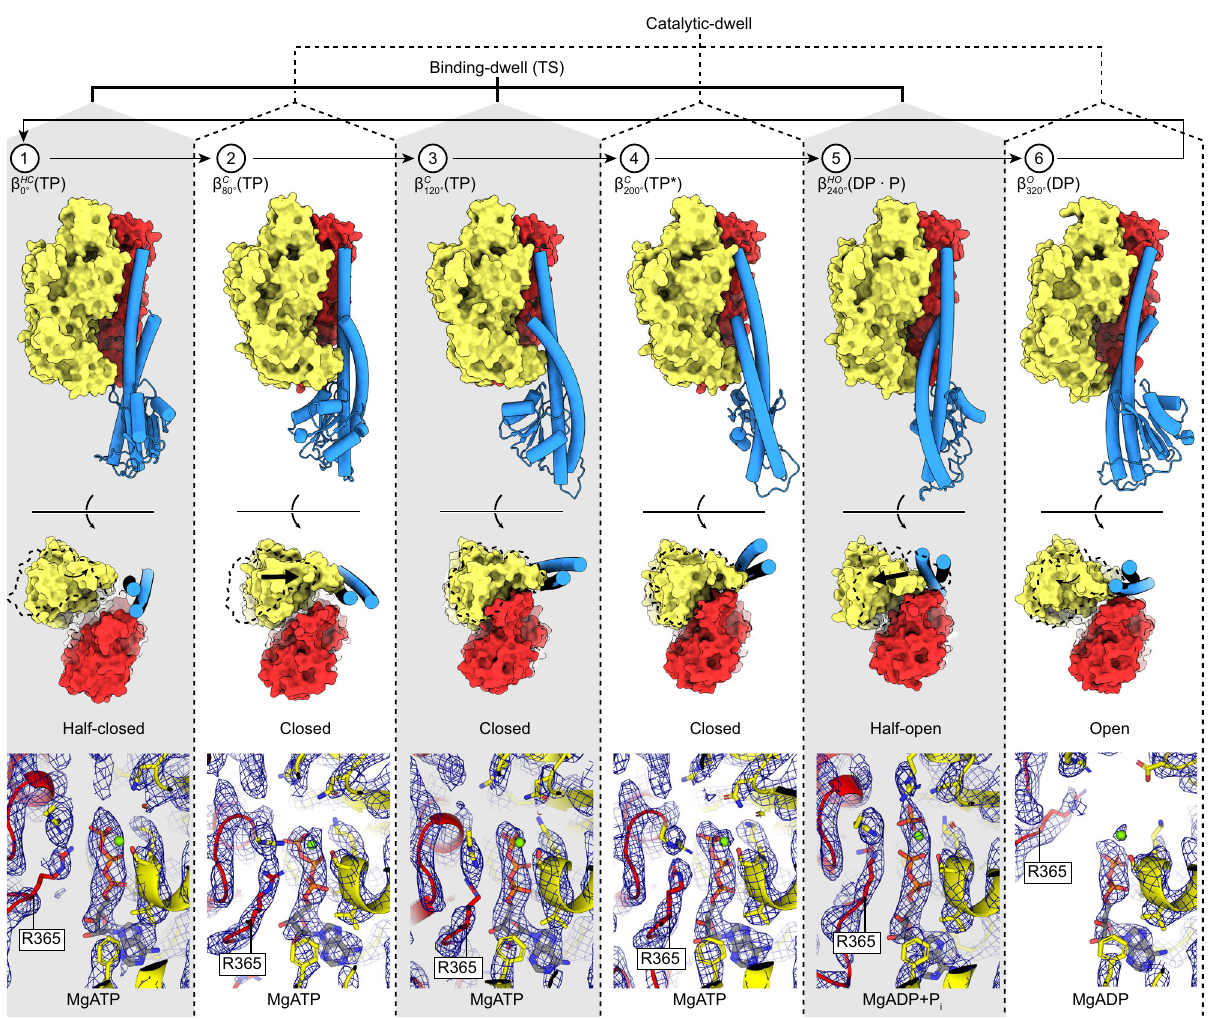
Fig. 3 The six sequential conformations in the F 1 -ATPase rotary catalytic cycle. Top, αβ -pairs superposed on the N termini ( β 2-82) and viewed from the side (perpendicular to the membrane) and below (from the membrane). Subunit α in red, β in yellow, and γ in blue, with stencil outline of the β -subunit from the previous step in the scheme for comparison. Bottom, close-up of the catalytic nucleotide-binding sites, superimposed on residues around the nucleotides ( β 158-166, β 336-342, and β 412-421). Cryo-EM map shown as blue mesh. Nucleotides, Mg 2 + , and P i are shown as sticks with CPK coloring and α R365 (the arginine fi nger) labeled. In the movement from the binding-dwell (TS) (states 1, 3, and 5) to the catalytic dwell (states 2, 4, and 6): 1 → 2 transition ( β HC TP ð Þ → β C TP ð Þ ), the αβ -subunits close to bind MgATP tightly. 2 → 3 → 4 Transition ( β C TP ð Þ → β C TP ð Þ → β C TP (cid:4) ð Þ ), the β -subunit 0 (cid:1) 80 (cid:1) 80 (cid:1) 120 (cid:1) 200 (cid:1) remains in a similar position, with a minor movement of the α -subunit about the nucleotide. 4 → 5 Transition ( β C TP (cid:4) ð Þ → β HO DP (cid:3) P ð Þ ), MgATP is 200 (cid:1) 240 (cid:1) hydrolyzed to MgADP + P i (elongated density in panel 5), and the β -subunit opens to a half-open state, with the arginine fi nger ( α R365) moving relative to the adenosine ring to stabilize the MgADP + P i . 5 → 6 Transition ( β HO DP (cid:3) P ð Þ → β O DP ð Þ ), P i is released and the β -subunit opens. 6 → 1 Transition 240 (cid:1) 320 (cid:1) ( β O DP ð Þ → β HC TP ð Þ ), MgADP is released, followed by MgATP binding and the β -subunit half closing to start the cycle 320 (cid:1) 0 (cid:1)